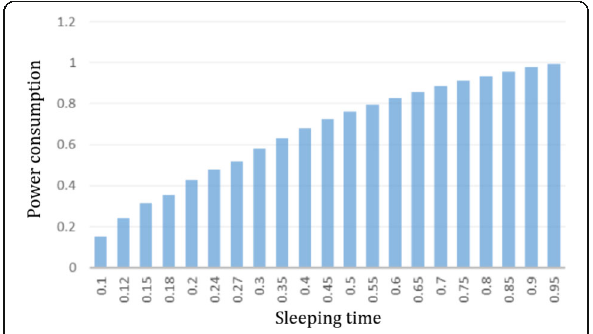
Fig. 6 The allocation rule of sleeping